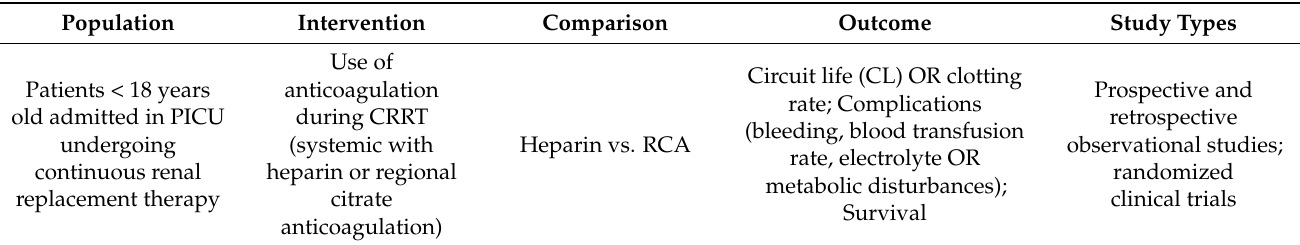
Table 1. PICO. PICU: pediatric intensive care